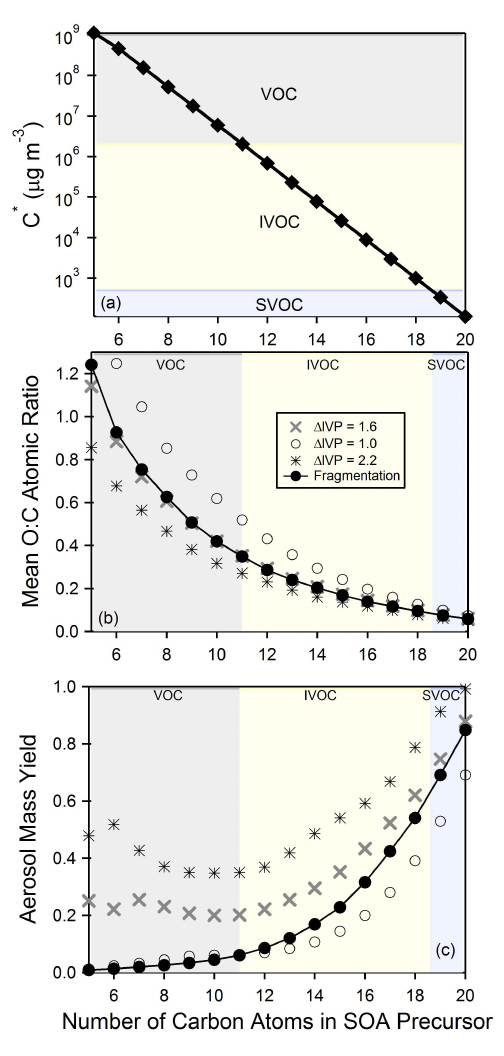
Fig. 2. (a) The relationship between volatility ( C ∗ , inµgm − 3 ) and number of carbon atoms (for a saturated hydrocarbon), showing the distinction between VOCs (gray), IVOCs (yellow) and SVOCs (blue). The calculated mean O:C (b) and aerosol mass yield (c) are shown as a function of the number of carbon atoms in the SOA pre- cursor. Results are shown for a variety of conditions with respect to changes in volatility upon oxygen addition and to fragmentation (see legend). All calculations are for C OA = 10µgm − 3 formed over 1 oxidation lifetime. Note that if the SOA precursors contained oxy- gen atoms, the VOC/IVOC/SVOC dividing lines would be shifted towards smaller N C .